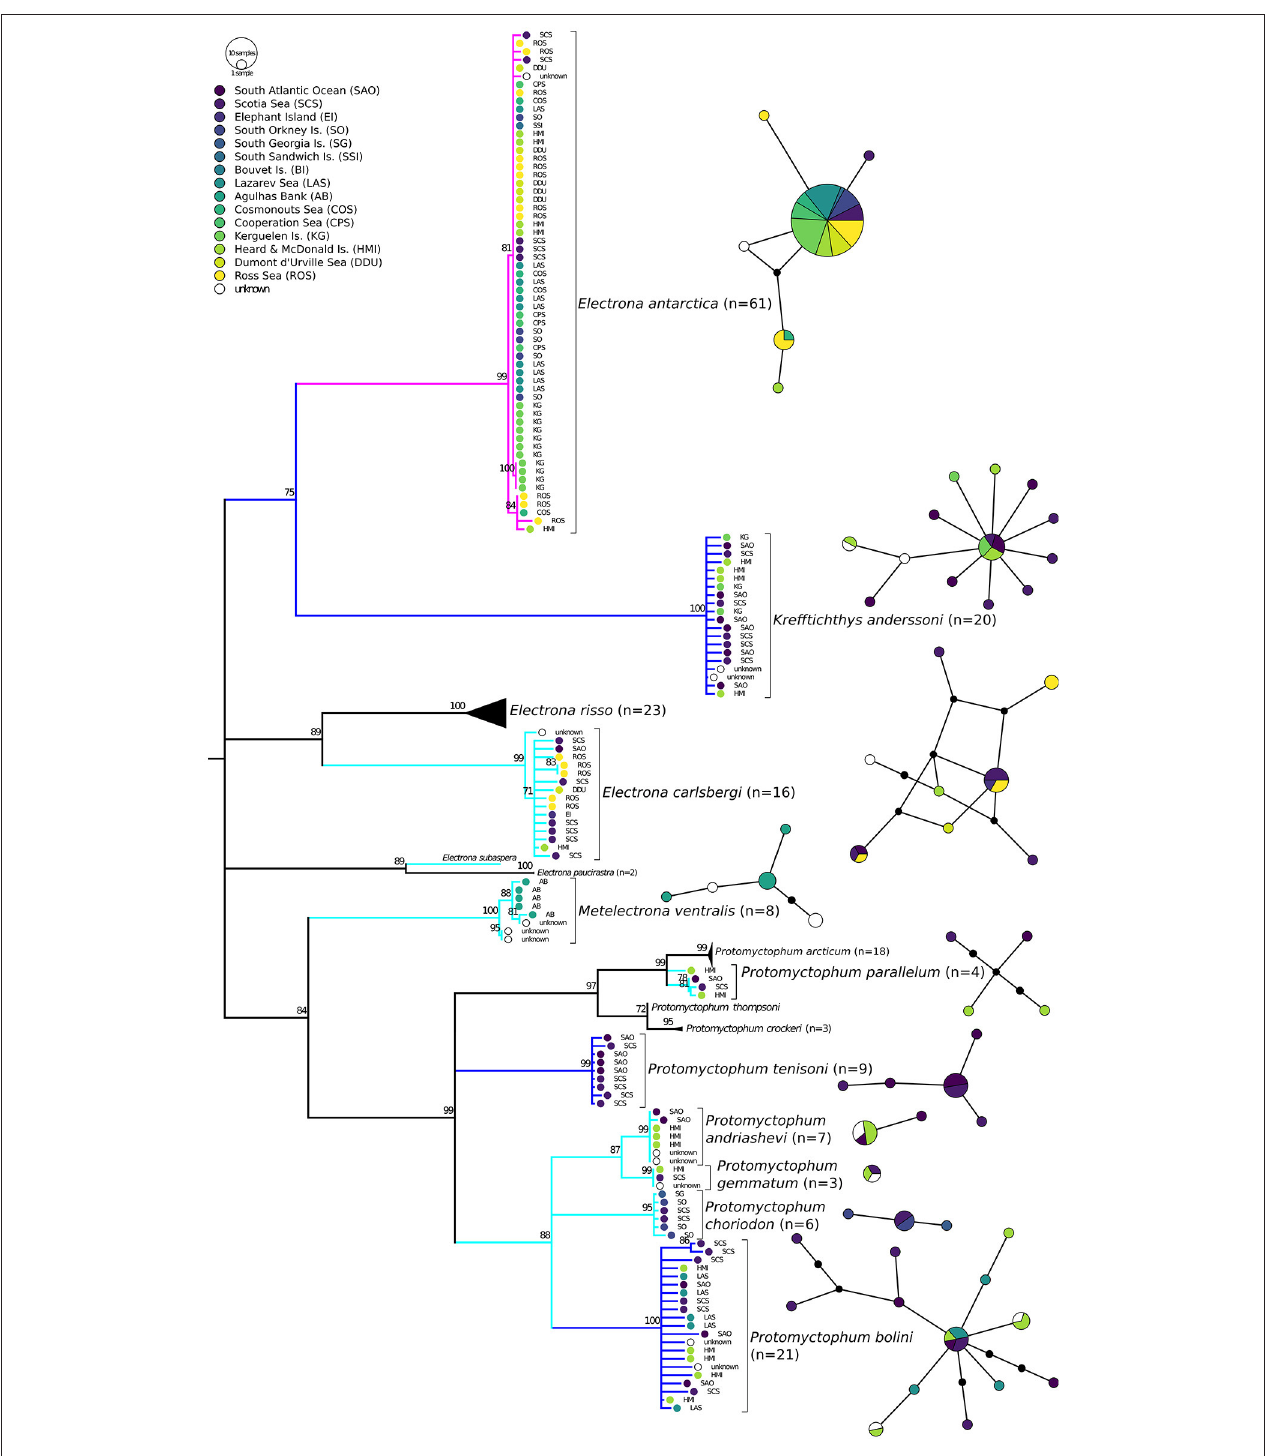
FIGURE 5 | Haplotype networks and phylogenetic consensus tree of myctophid fishes of the tribe Electronini ( sensu Paxton, 1972) based on cytochrome c oxidase I ( COI ) gene variation using a maximum likelihood analysis with 10,000 bootstrap permutations. Bootstrap support > 70 is shown above the branches; branches with lower support are collapsed to polytomies. Branches of species with Antarctic, broadly Antarctic, and sub-Antarctic distribution pattern following Duhamel et al. (2014) are depicted in purple, dark blue, and light blue, respectively (color figure available online). Geographic origin is reflected by colored circles in the tree and networks, approx. clockwise from West (dark) to East Antarctic (light). In the haplotype networks one branch represents one mutation. Additional mutation steps between samples are indicated with small black circles.